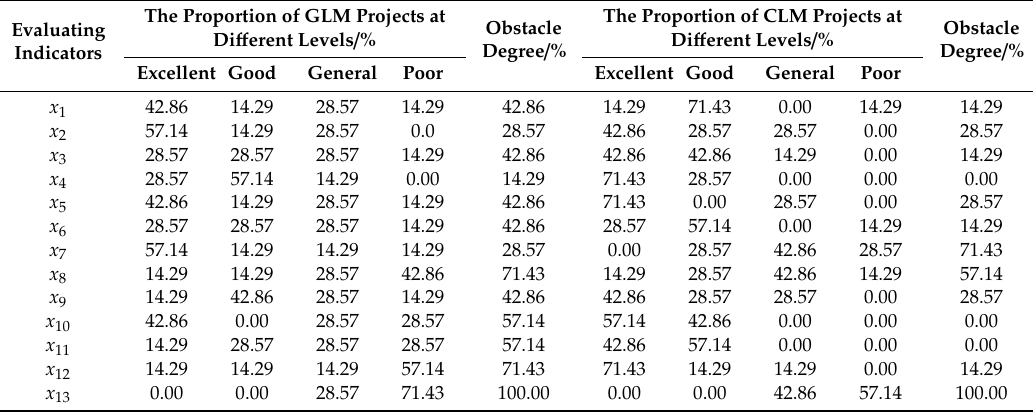
Table 6. Statistic of influencing factors of performance of LCPs in the two